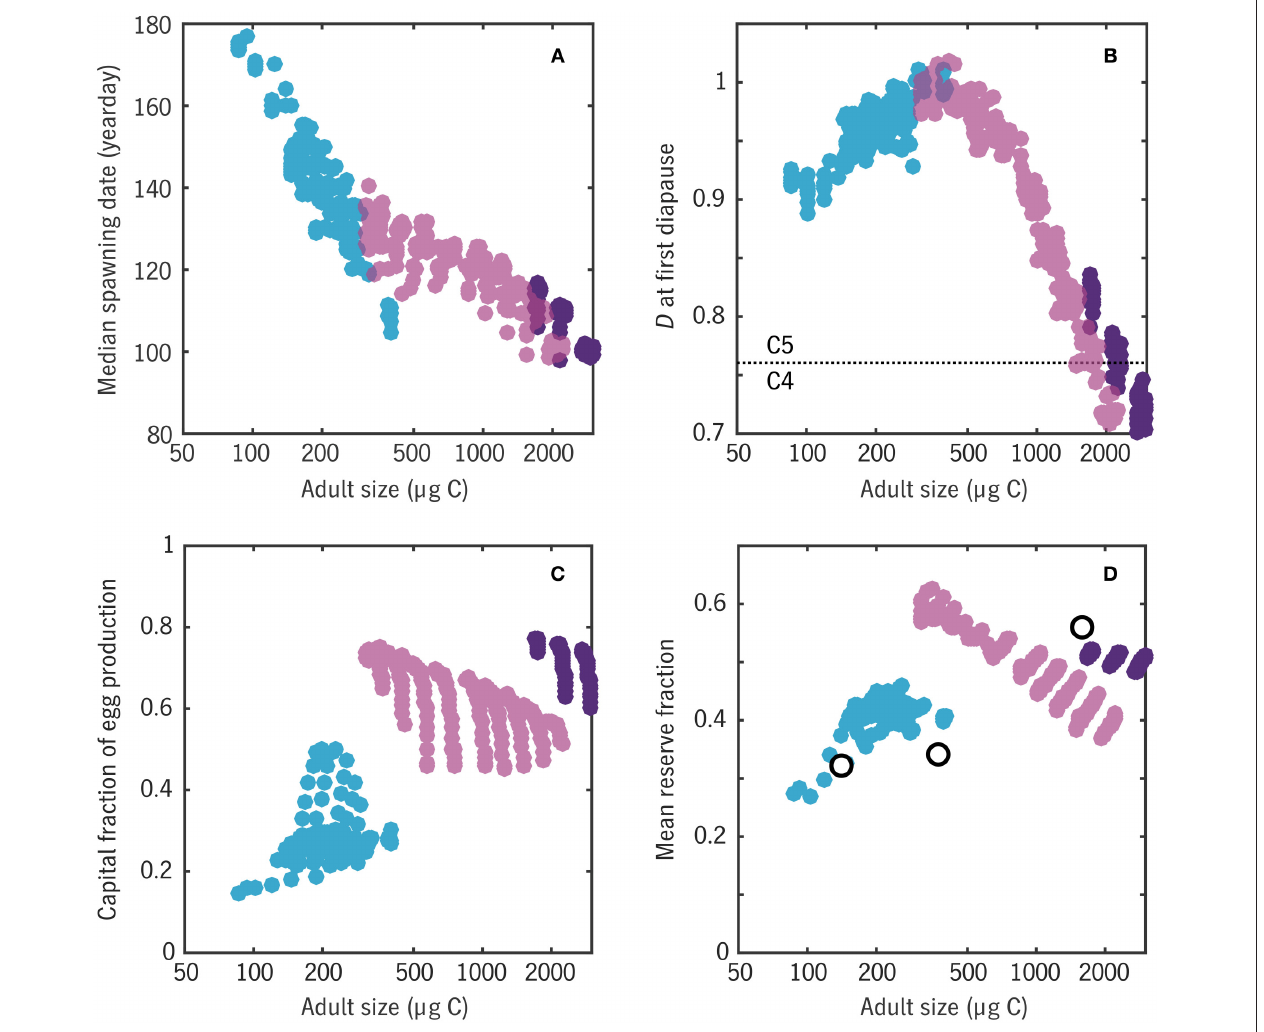
FIGURE 12 | Relationships between a number of emergent traits with adult body size in the Disko Bay experiment. Color coding matches Figure 10 , distinguishing 1-year (blue), 2-year (light purple), and 3-year (dark purple) life cycles. (A) Median spawning date: cf. peaks of egg production curves in Figure 11 . (B) Earliest developmental stage D at which diapause ( a = 0) occurs: values have been jittered slightly in the vertical for clarity. (C) Capital fraction of egg production E cap / ( E inc + Ecap ). (D) Mean reserve fraction of individual biomass R / ( R + S ), compared with wax esters as a fration of total body carbon for three Calanus spp. from Swalethorp et al. (2011) (open circles).